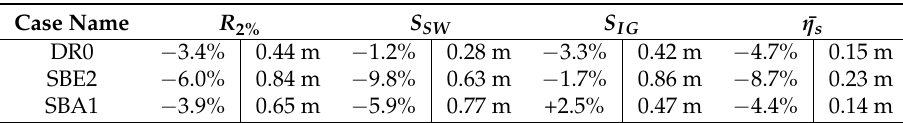
Table 5. Relative errors of the R 2% and the different runup components. Values from the numerical model are shown after the vertical